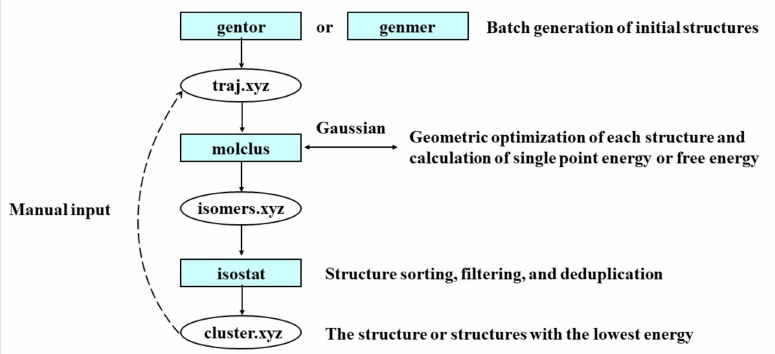
Figure 8. The workflow of theoretical